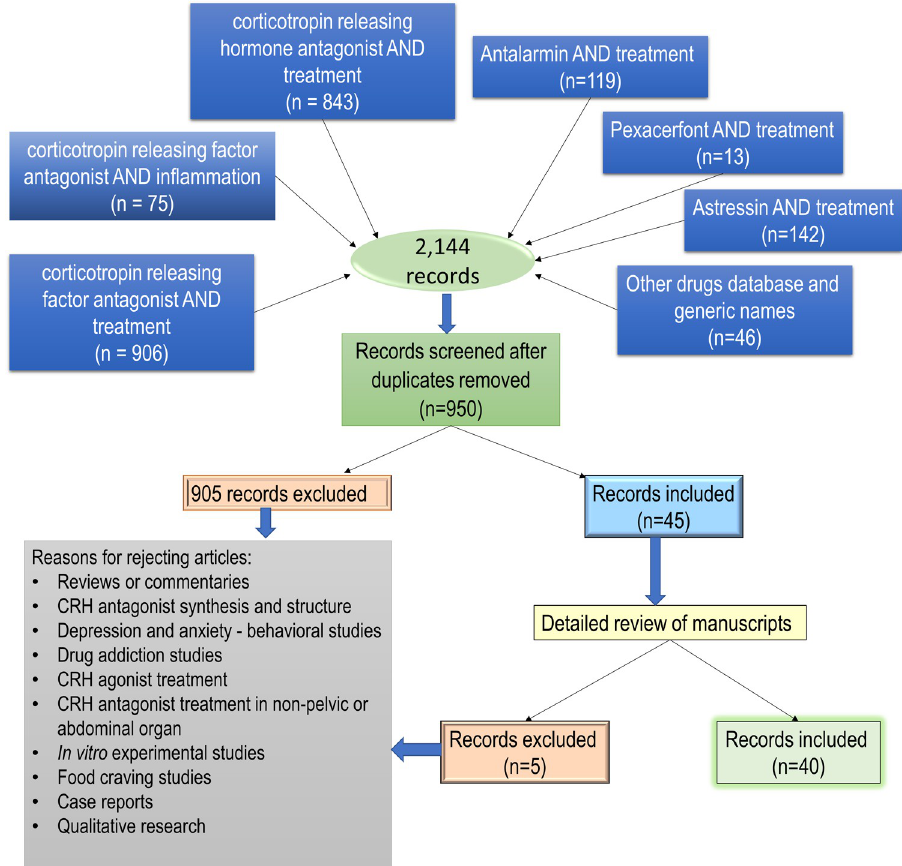
Fig 1. Article search results. Diagram depicting the number of articles found for the search strategies as established by the PRISMA guidelines.